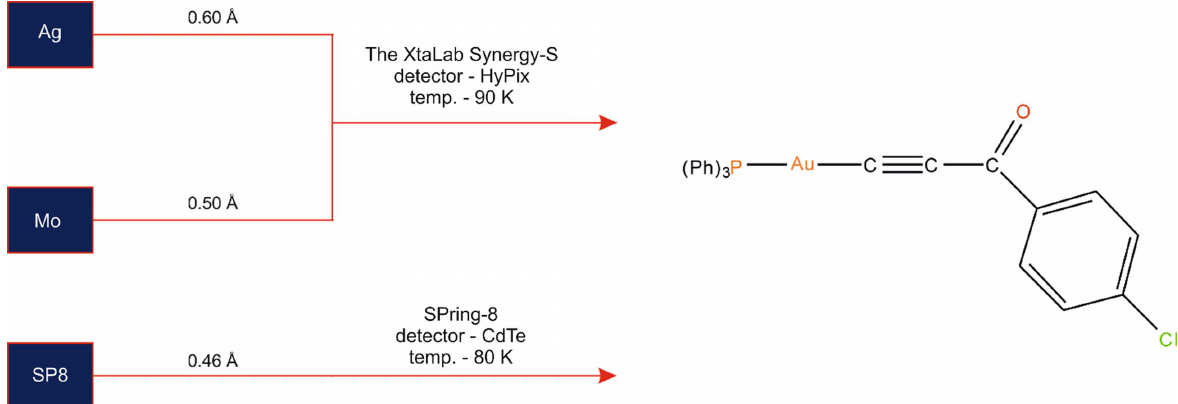
Figure 3 Scheme of X-ray experiments performed with applied resolution cut-offs.